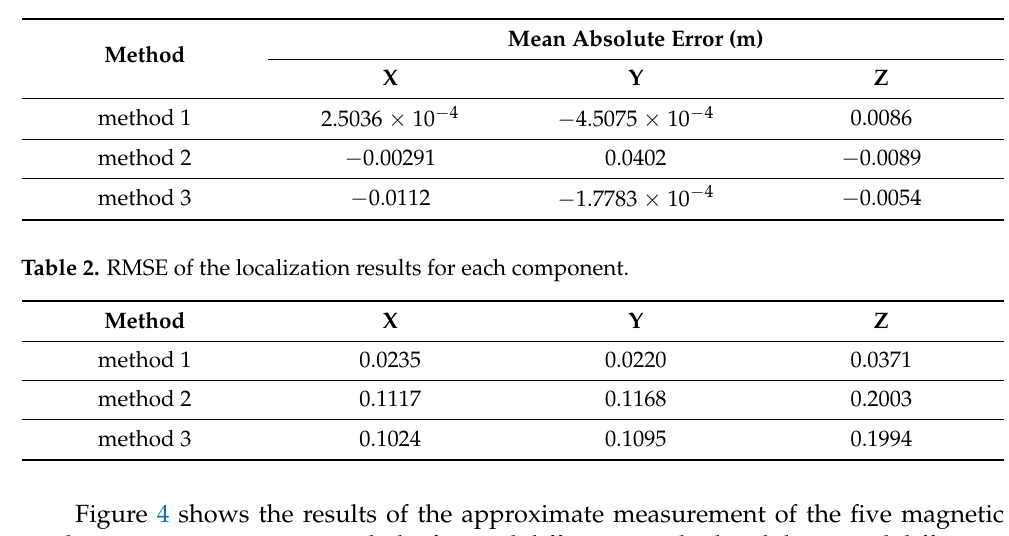
Mean Absolute Error (m)